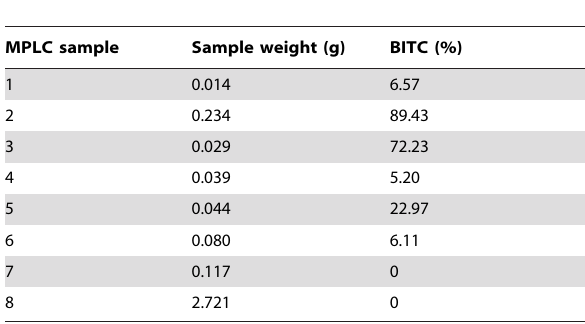
Table 1 . Benzyl isothiocyanate (BITC) in pooled MPLC-